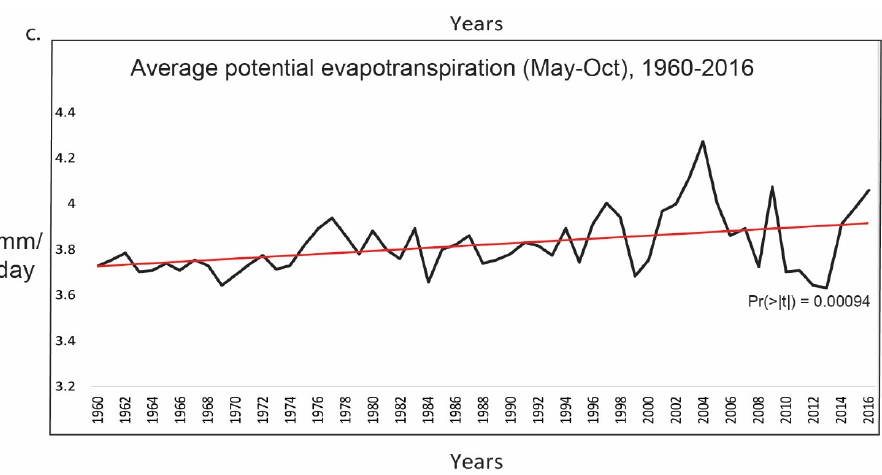
Figure 5. ( a ) Historical average temperature for the rainy season (May to October) in the area of interest for the period 1979 to 2019; the temperature is given in degrees C (data obtained from [29]). ( b ) Historical average precipitation for the rainy season (May to October) in the area of interest for the period 1981 to 2018; precipitation is given in mm/day (data obtained from [30]). ( c ) Historical average evapotranspiration for the rainy season (May to October) in the area of interest from 1960 to 2016; evapotranspiration is given in mm/day (data obtained from [29]). The black lines represent the historical data and the red lines represent the linear tendencies. p values (Pr(>|t|)) are given for the lineal regression t-test for each model; statistical significance was considered when Pr(>|t|) < 0.05.